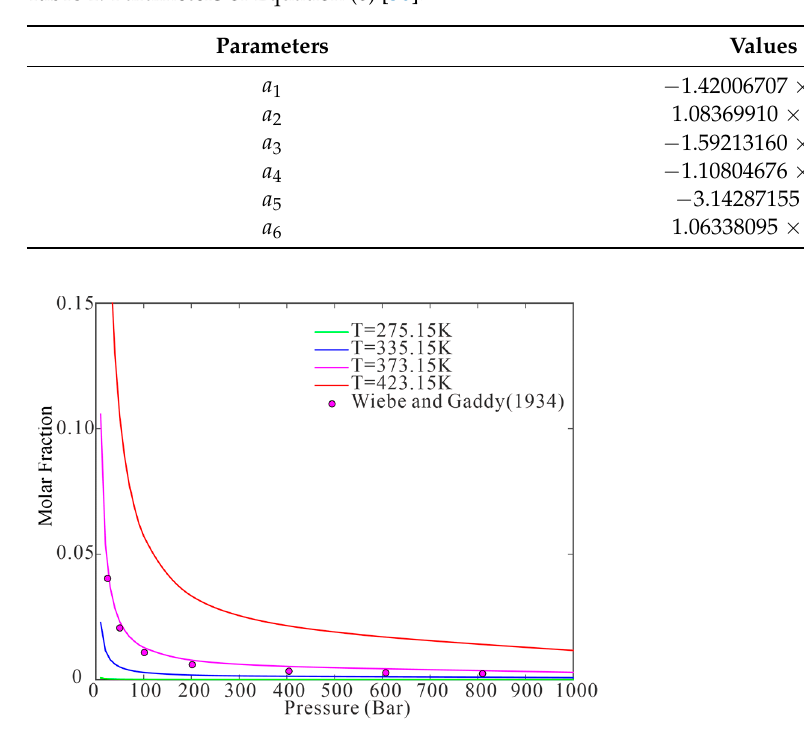
Table 1. Parameters of Equation (6) [30].